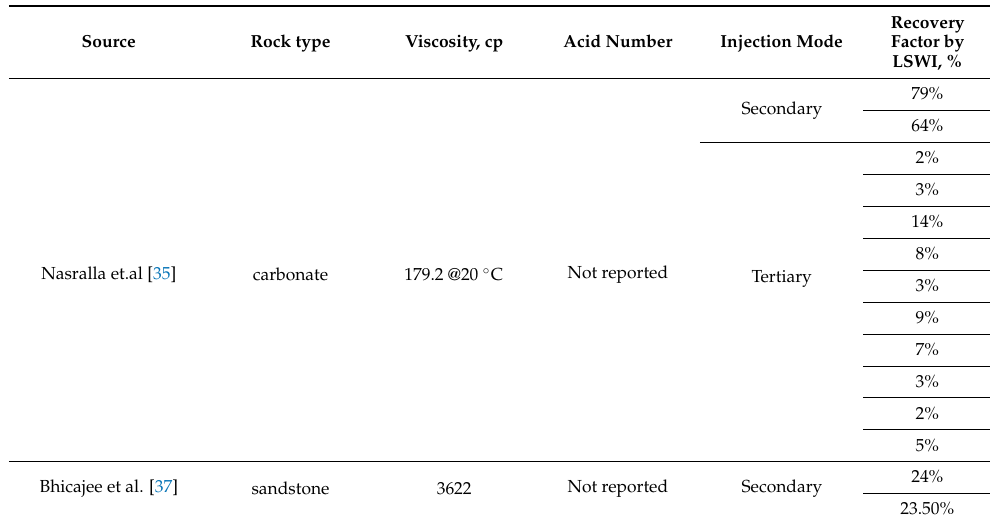
Table 4. Data reported in the literature for the LSWI to heavy oil formations.